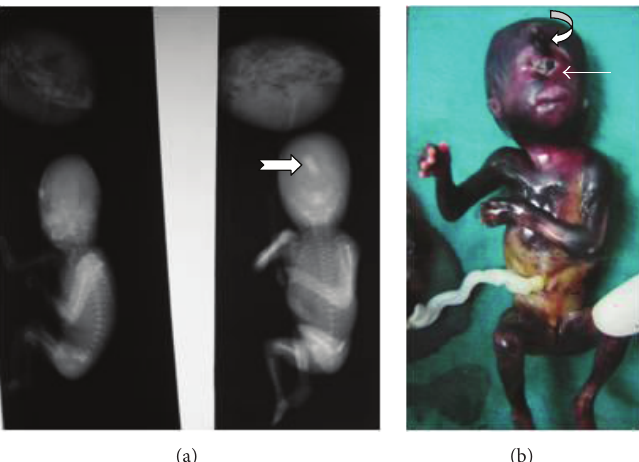
Figure 3: (a) Radiograph of the specimen with the placenta showing the proboscis (notched white arrow) as a dense structure in the frontal regionandnormalspine.(b)Photographofthespecimenshowingfacialdysmorphism,proboscis(curvedwhitearrow),andcyclopia(straight white